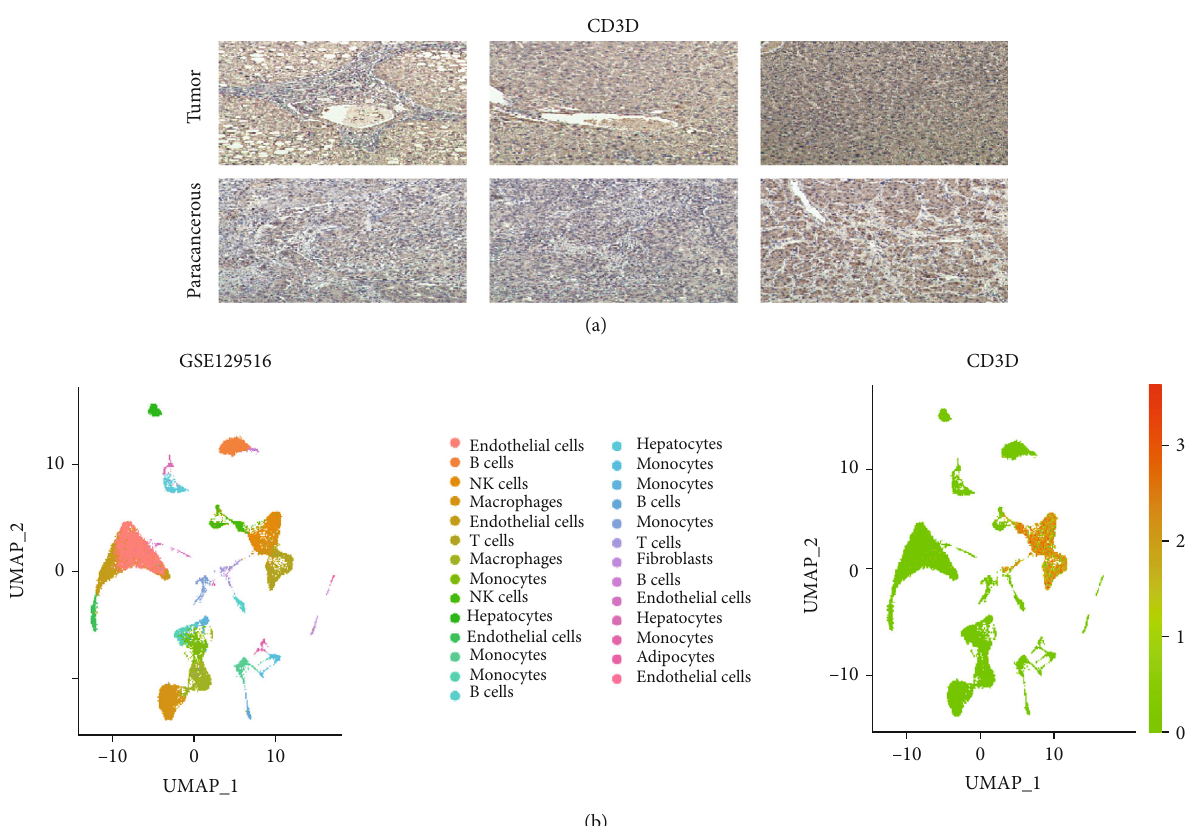
Figure 9: (a) Immunohistochemical analysis in tumor and paracarcinoma tissues from China Medical University clinical samples. (b) Single- cell cohort validation in